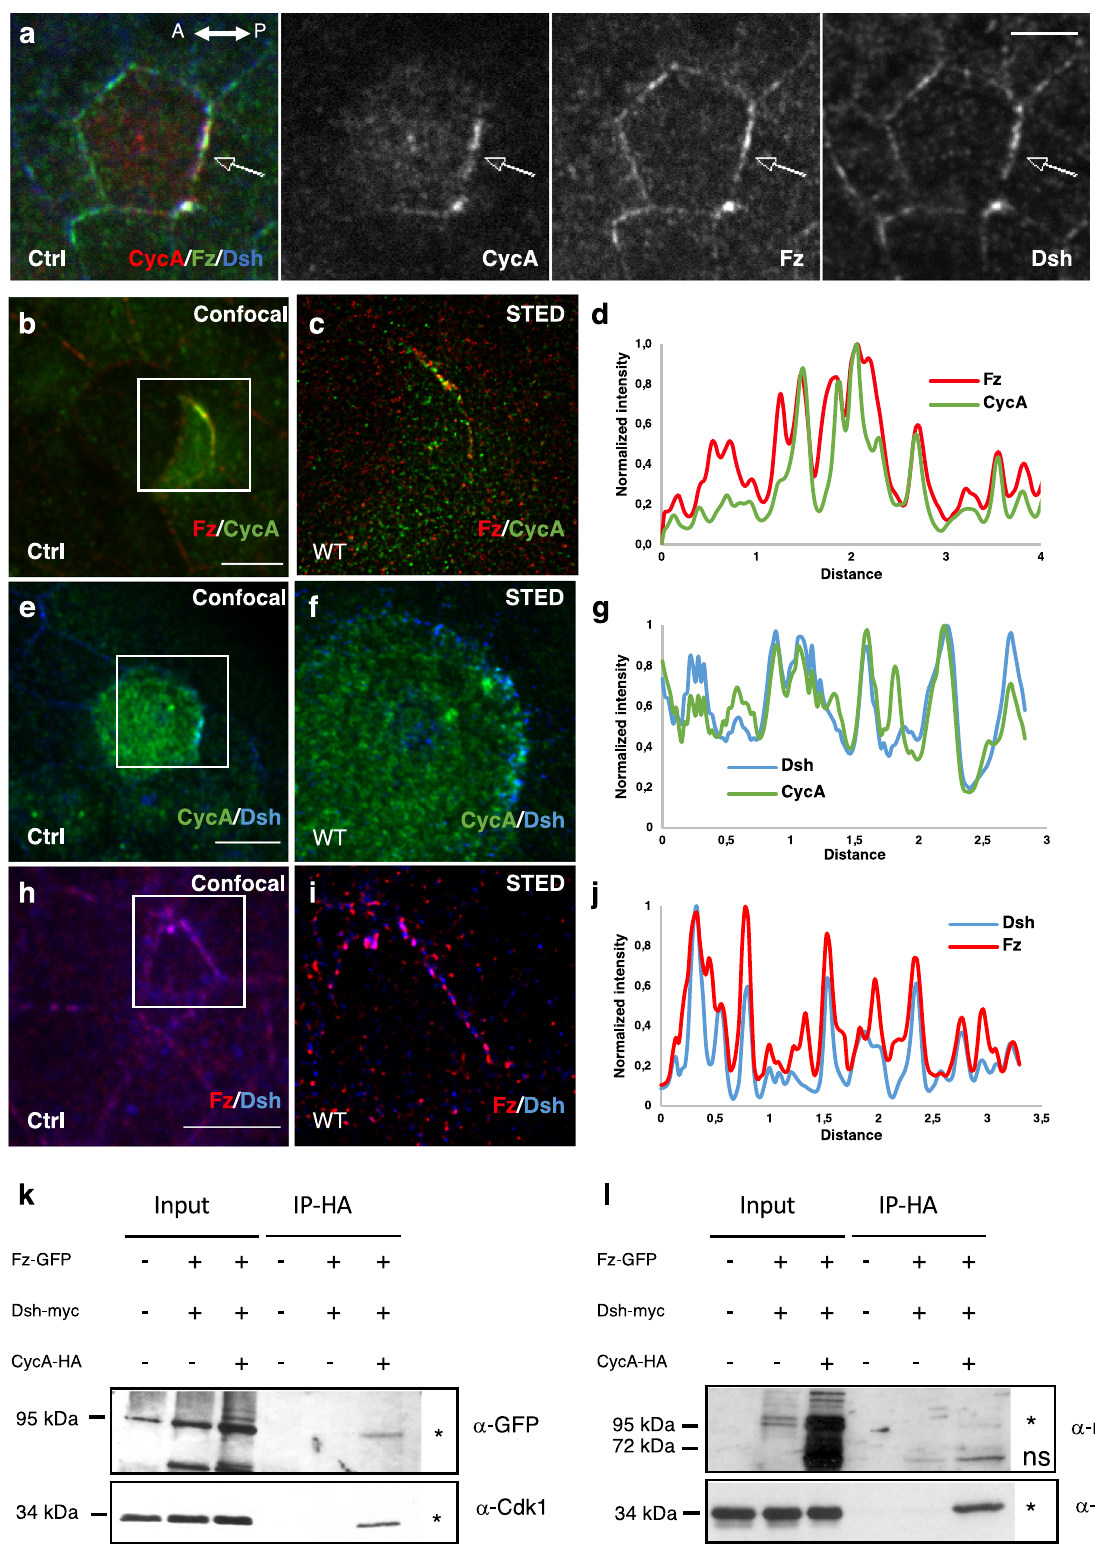
Apical-posterior cortical localization of CycA is dependent on PCP factors . The apical-posterior cortical localization of CycA was reminiscent of that observed for Fz and Dsh, two PCP fac- tors. This prompted us to investigate whether there is any interplay between CycA and PCP by two